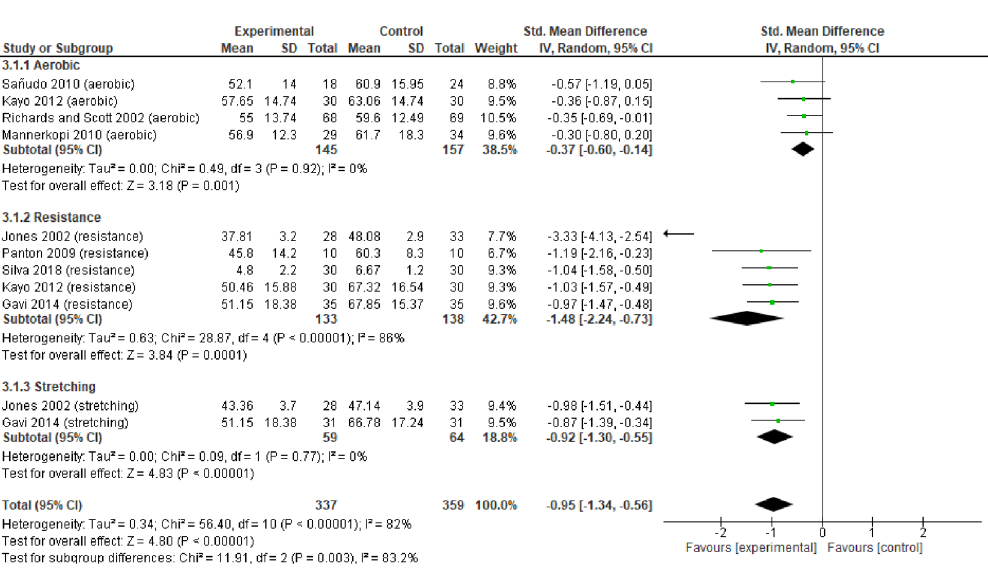
Figure 6. Forest plots showing the effect of training on FM Impact on quality-of-life